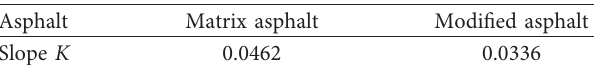
Figure 6: The relationship between the capacitance of modified asphalt film and soaking time. Table 7: Slope K of curve.